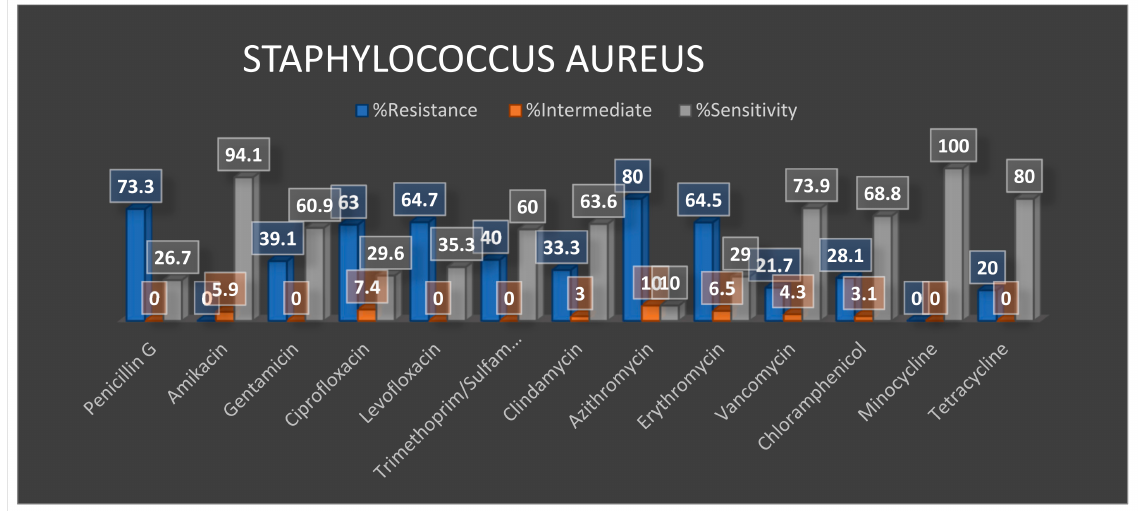
Figure 8. Distribution of antimicrobial susceptibility profiles of S. aureus across different available